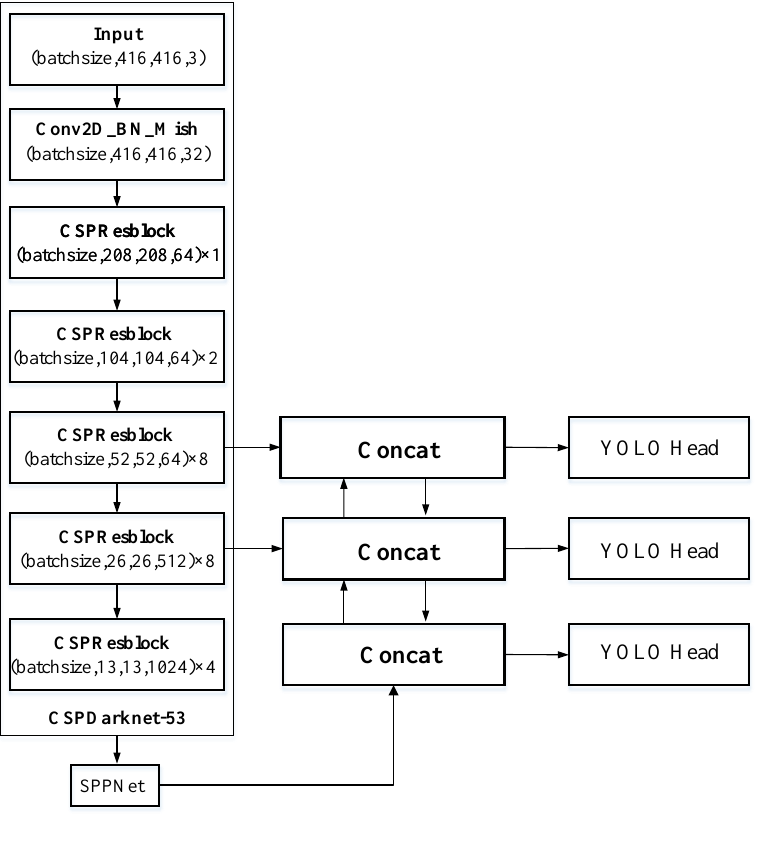
Figure 5. The CSYOLOv3 model